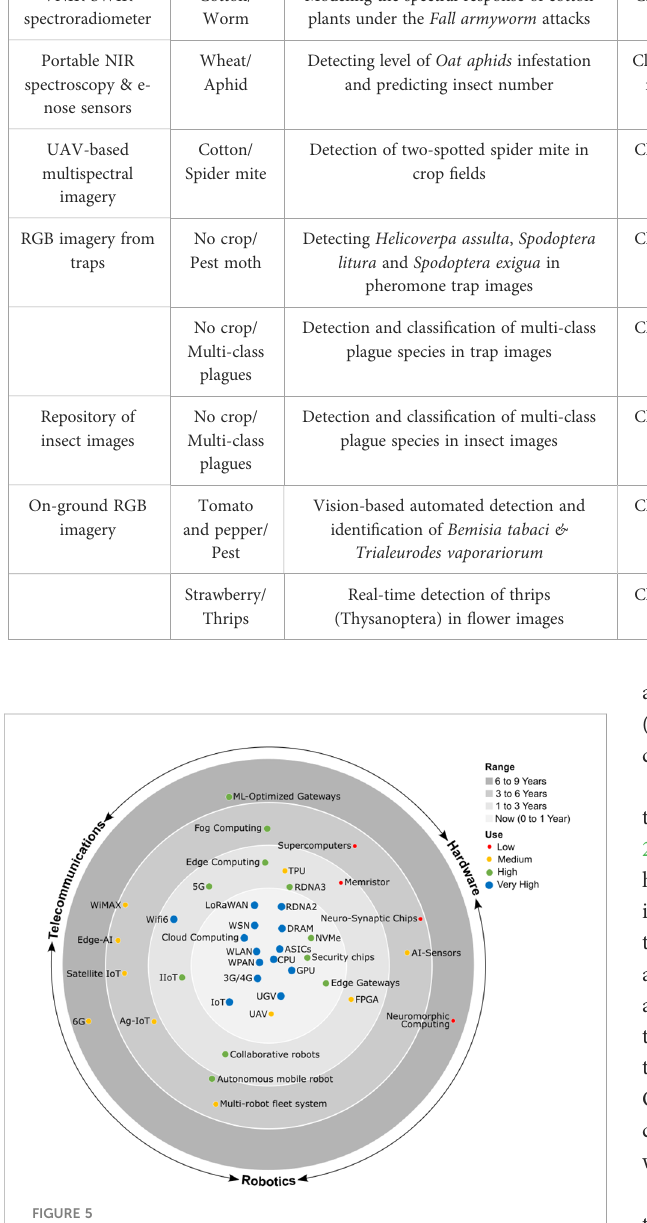
FIGURE 5 Multidisciplinary technological domain of Ag5.0 with a different degree of maturity and use ranging from mature technologies in the core circle to future technologies in the peripheral circle. CPU, central processing unit; GPU, graphics processing unit; TPU, tensor processing unit; DRAM, dynamic random-access memory; RDNA, radeon DNA; NVMe, non-volatile memory express; ASIC, application speci fi c integrated circuit; FPGA, fi eld programable gate array; LPWAN, low power wide area network; WLAN, wireless local area network; WPAN, wireless personal area network; WSN, wireless sensor network; IoT, internet of things; IIoT, industrial IoT; Ag-IoT, agricultural IoT; LiFi, light fi delity; WiMAX, worldwide interoperability for microwave access; TSN, time-sensitive networking; xG, cellular network